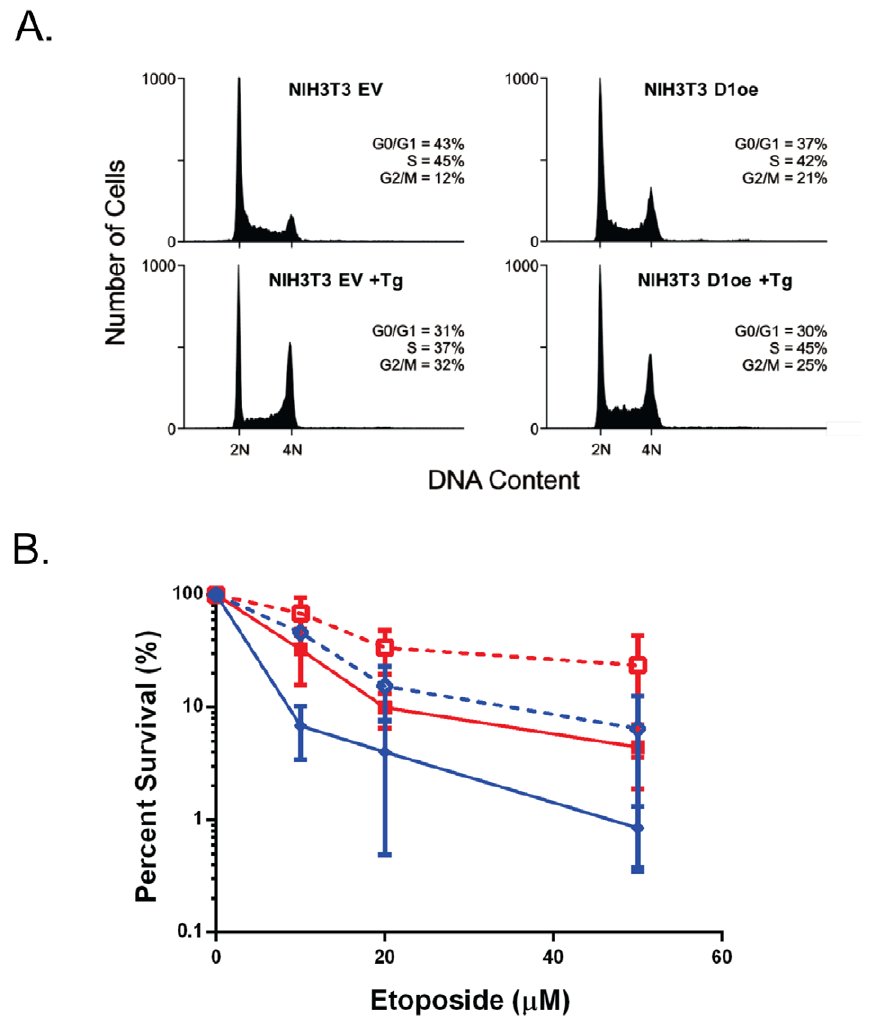
Figure 5. Decreased sensitivity to etoposide is not due to UPR-induced cell cycle arrest. A. NIH3T3 cells were transduced with a retrovirally transduced with an empty vector (ev) or a stable version of cyclin D1 (D1oe) and cell cycle analyses were performed after 0 and 6 h thapsigargin treatment. B. The same cells were plated for clonal survival assays.